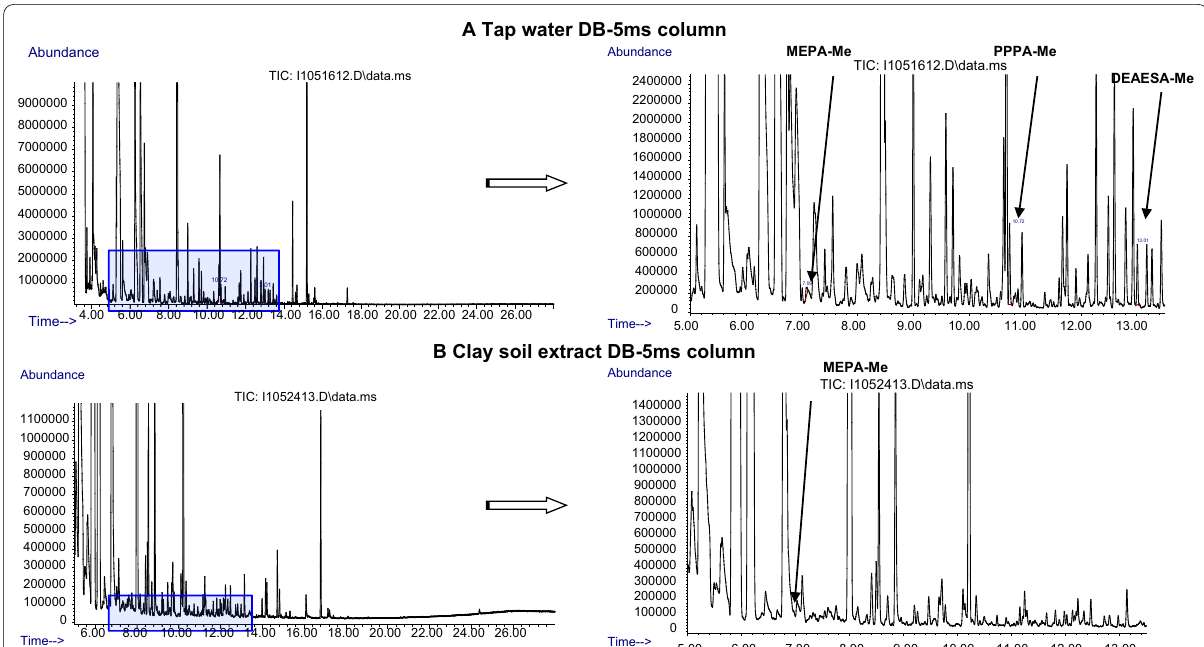
Fig. 6 GC–MS TICs of non‑cation‑exchanged tap water sample ( A ) and a clay soil extract ( B ). TMSDAM was used for methylation and a DB‑5 ms column for analysis